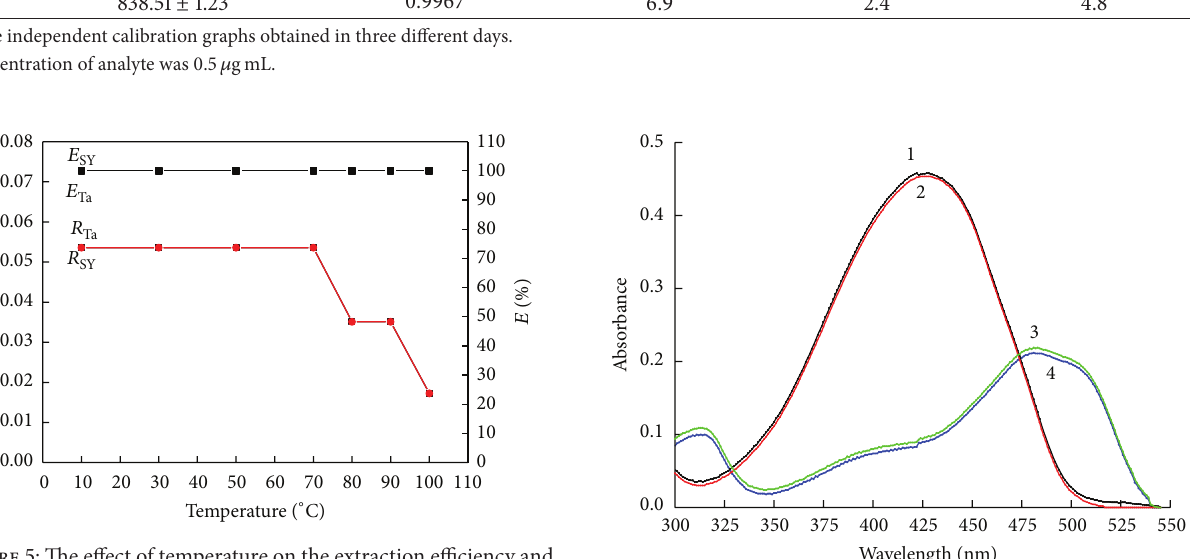
Figure 5: The effect of temperature on the extraction efficiency and phase ratio.